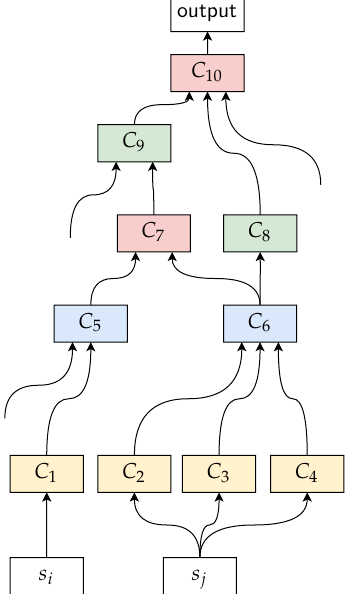
Figure 13. An example of architecture constructed using the architectural components depicted in Figure 12. The nodes s i and s j correspond to the data